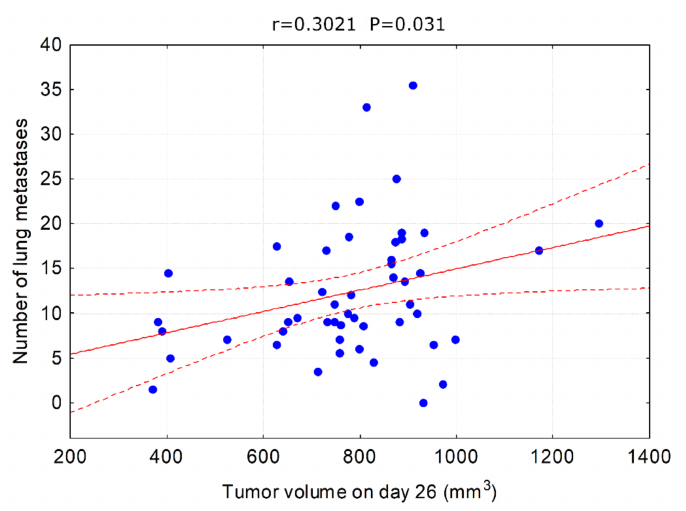
Figure 9. Correlation between tumor volume on day 26 and the number of lung metastases. All animals used in the experiment are analyzed